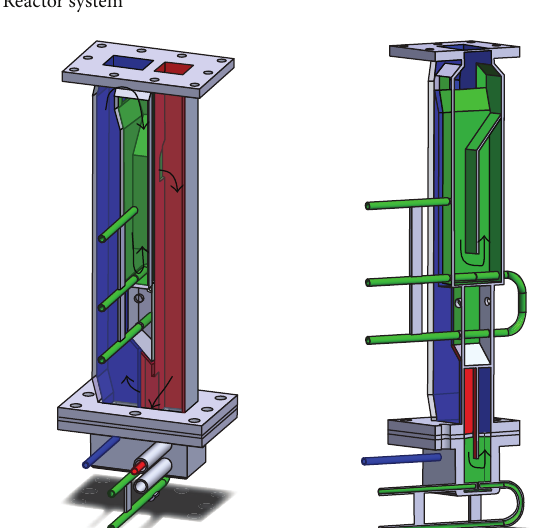
Figure 2: The reactor. Arrows are showing the flow direction of the particles. The air reactor is in blue, the fuel reactor is in red, and the downcomer and slot loop seals are shown in green. The pipes are the various gas inlets. In the slot and downcomer the bottom gas inlets consist of two separate pipes in order to distribute the gas evenly between the fuel reactor and air reactor side. In the downcomer one additional gas inlet sits at about half height and can be used in case of fluidization difficulties. Not shown in the image is the widened settling zone where the gas velocity is reduced so that particles fall back down into the reactor. Image courtesy of Patrick